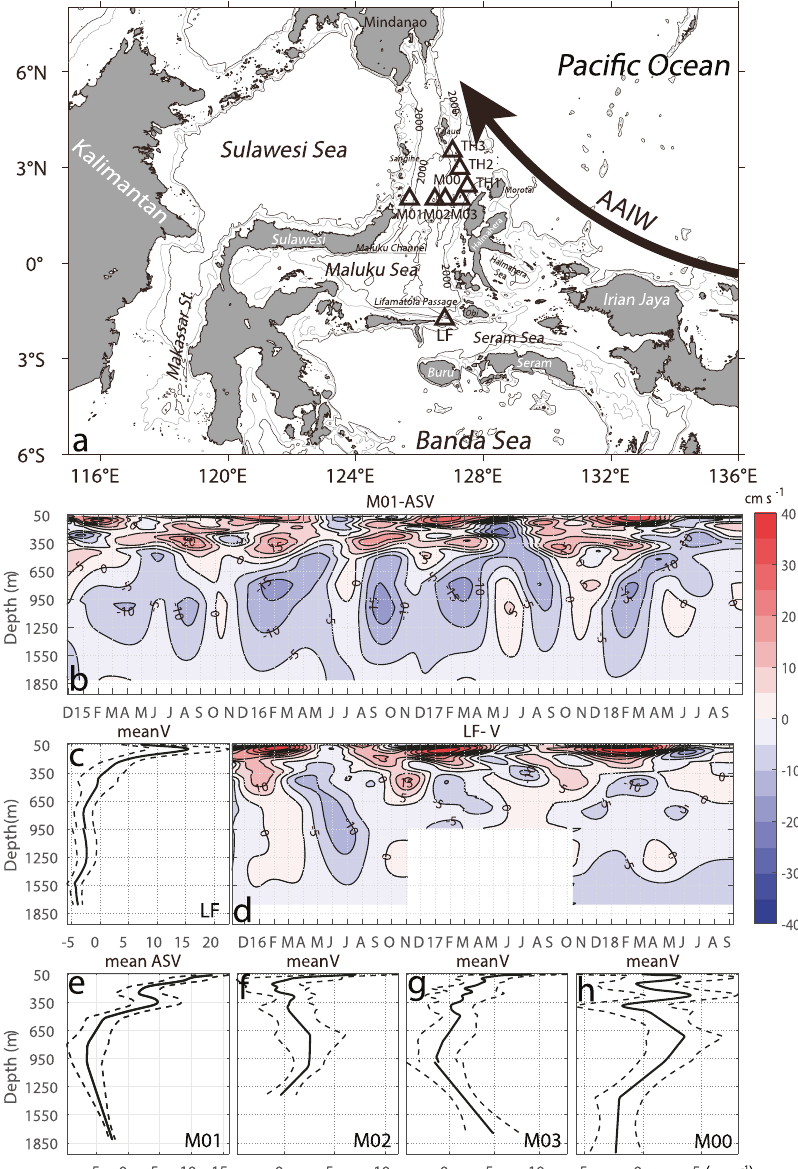
Fig. 1 Mooring observations of Maluku Sea currents. a Map and locations of the eastern Indonesian sea moorings, with topography (unit in meters). The moorings from west to east are M01, M02, M00, M03 in the Maluku Channel. The big arrow in ( a ) mark the movement of the Antarctic intermediate water (AAIW) in the tropical western Paci fi c Ocean. 120-day low-passed daily mooring velocity at the sites of M01 and in the Lifamatola Passage ( b , d ), showing the mean intermediate depth western boundary current at the depth between 450 m and 1000m ( e – h ) connecting to the southward fl ow at the same depth in the Lifamatola Passage ( c ). The along strait velocity (ASV) at M01 follow the coasts at an angle of 12° from due north. Only the meridional velocity is shown at M02, M00, and M03, due to lack of guidance by the coasts and the topography. The meridional velocity component is shown at the LF mooring, because the currents direction rotates signi fi cantly in the upper 1200 m, not following the thalweg in general. Dash lines mark the standard errors of the means at 95% signi fi cance. Contour interval is 5 cm s − 1 . The data blank in ( b ) is due to failure of an RCM at 1800 m from November 2016